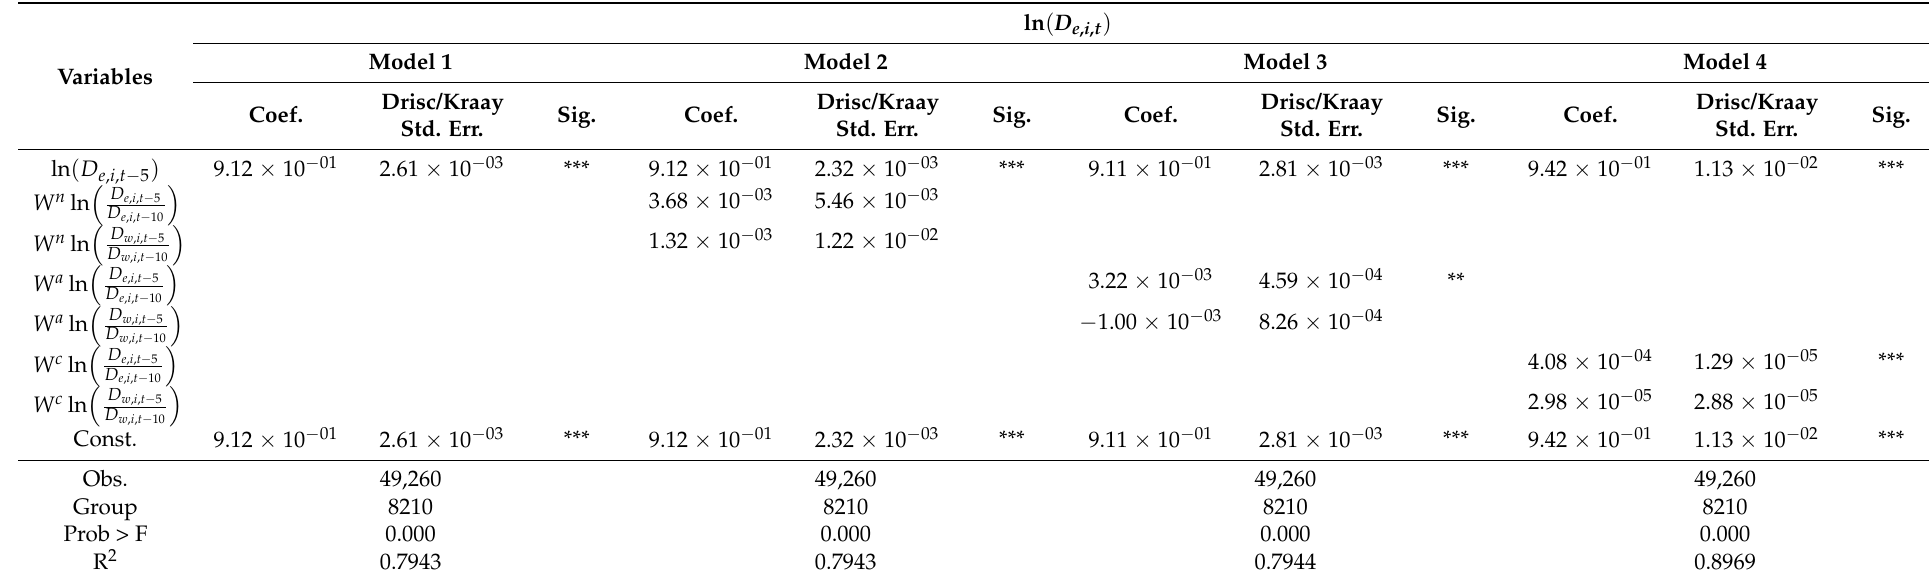
Table 1. Predicting job density based on three different spatial matrices.